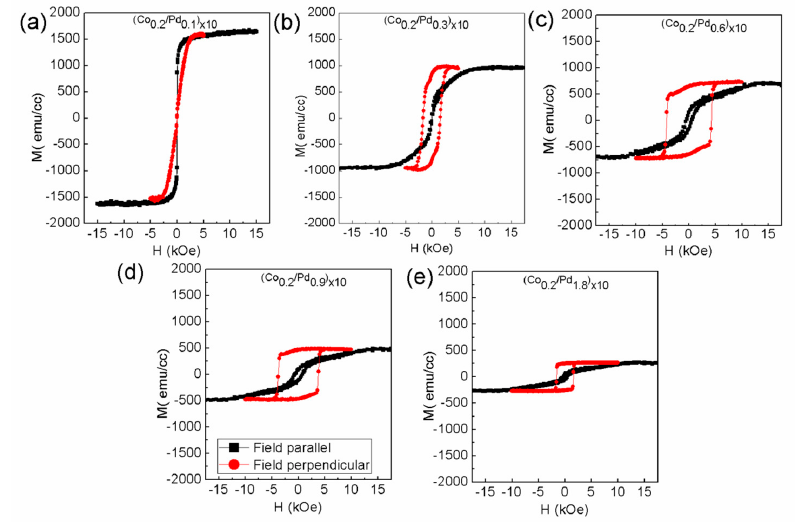
Figure 6. In-plane (black square) and out-of-plane (red circle) magnetic hysteresis loops of sample ( a ) (Co 0.2 /Pd 0.1 ) ×10 , ( b ) (Co 0.2 /Pd 0.3 ) ×10 , ( c ) (Co 0.2 /Pd 0.6 ) ×10 , ( d ) (Co 0.2 /Pd 0.9 ) ×10 , ( e ) (Co 0.2 /Pd 1.8 ) ×10 of series 3 with (Co 0.2 /Pd t ) ×10 .